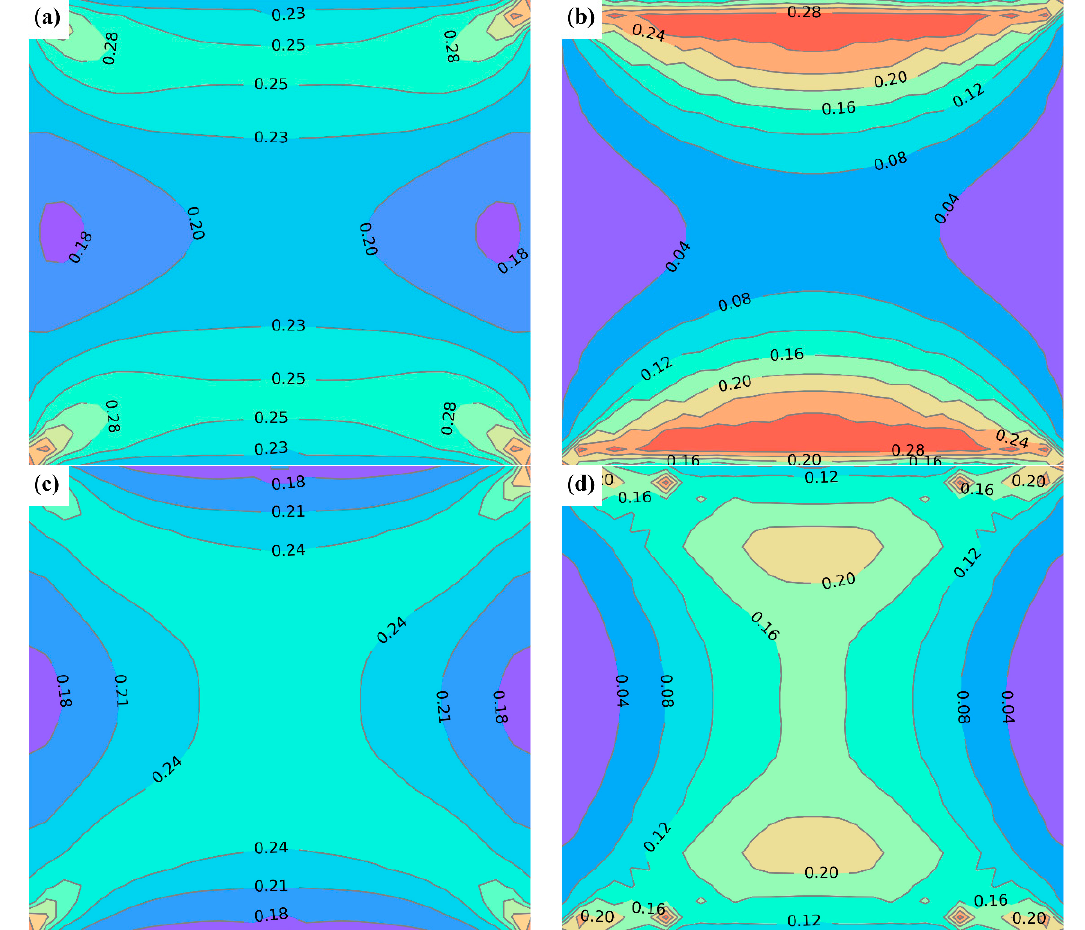
Figure 6. Simulation results of first pass of Plate A and RP process of Plate B: ( a ) equivalent strain of first pass of Plate A; ( b ) Q of first pass of Plate A; ( c ) equivalent strain of RP process of Plate B; ( d ) Q of RP process Plate B.